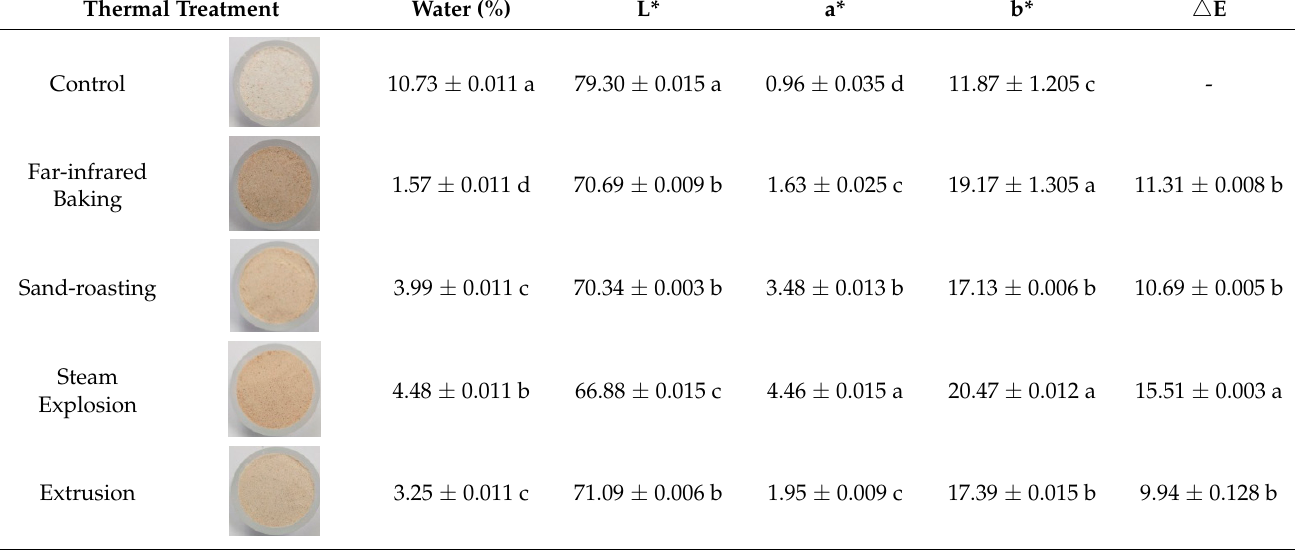
Table 1. Effect of thermal treatment on colour of whole grain highland barley flour. Thermal Treatment